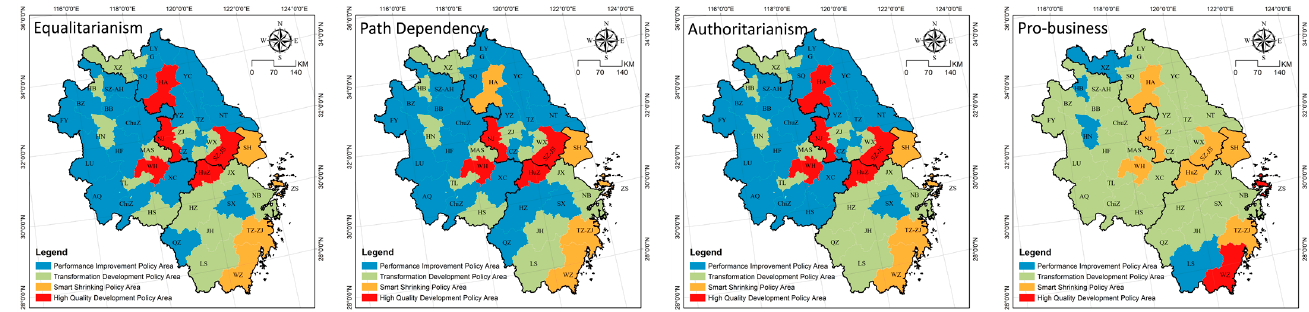
Figure 14. Analysis of the zoning management in the YRD .